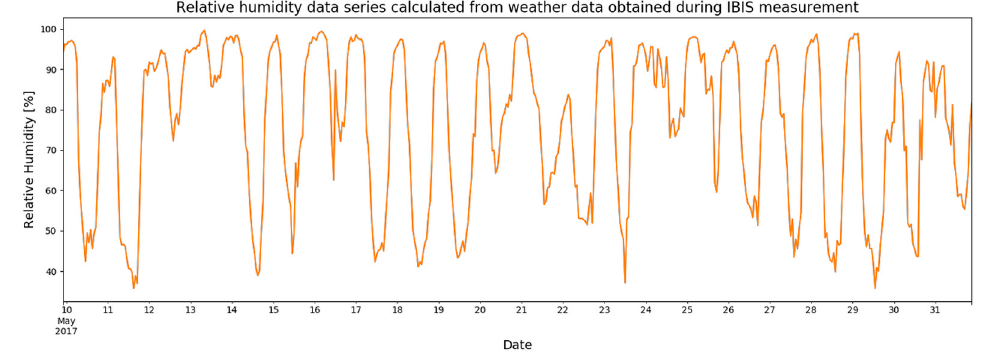
Figure 15. Relative humidity data series calculated from the weather data as obtained during the IBIS